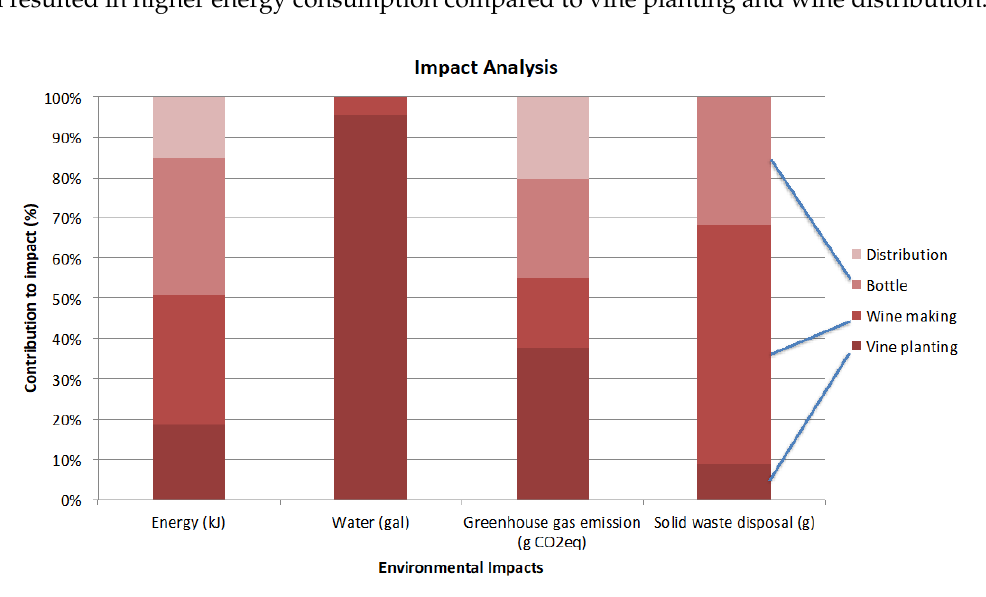
Figure 2. Allocation of environmental emissions to various segments of the wine life cycle.